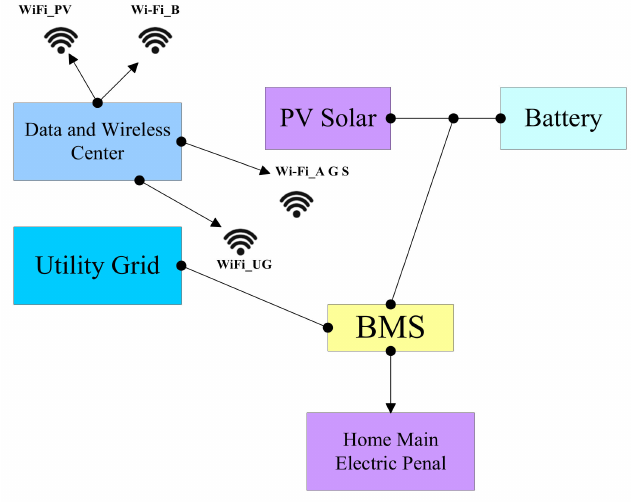
Figure 4. Connections of a battery-management system and its integration